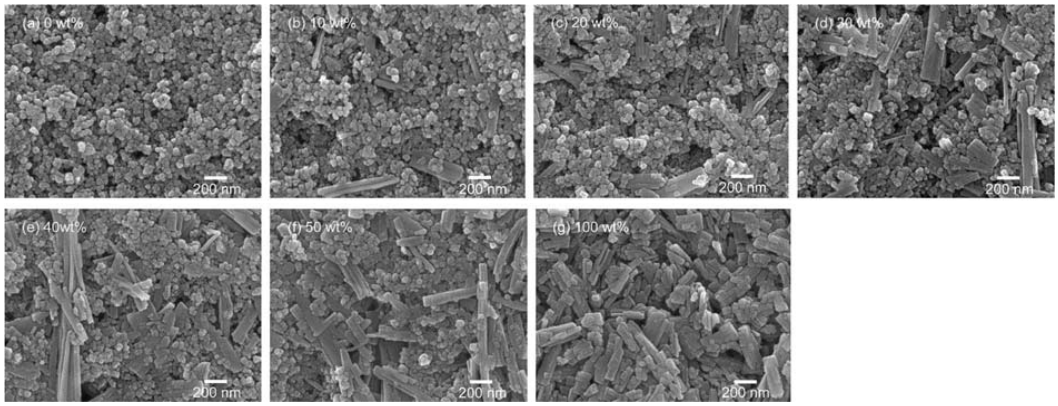
Fig. 5 SEM micrographs of DSC top surface view: TiO 2 (B) nanowire contents were (a) 0 wt%, (b) 10 wt%, (c) 20 wt%, (d) 30 wt%, (e) 40 wt%, (f) 50 wt%, and (g) 100 wt%,